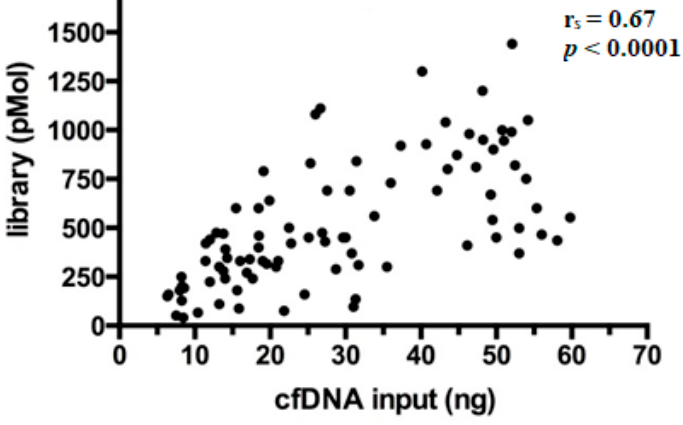
Figure 2. Correlation between library yields and cfDNA input. Each dot in the scatterplot represents the single library prepared (n = 92) and the relative concentrations are expressed in